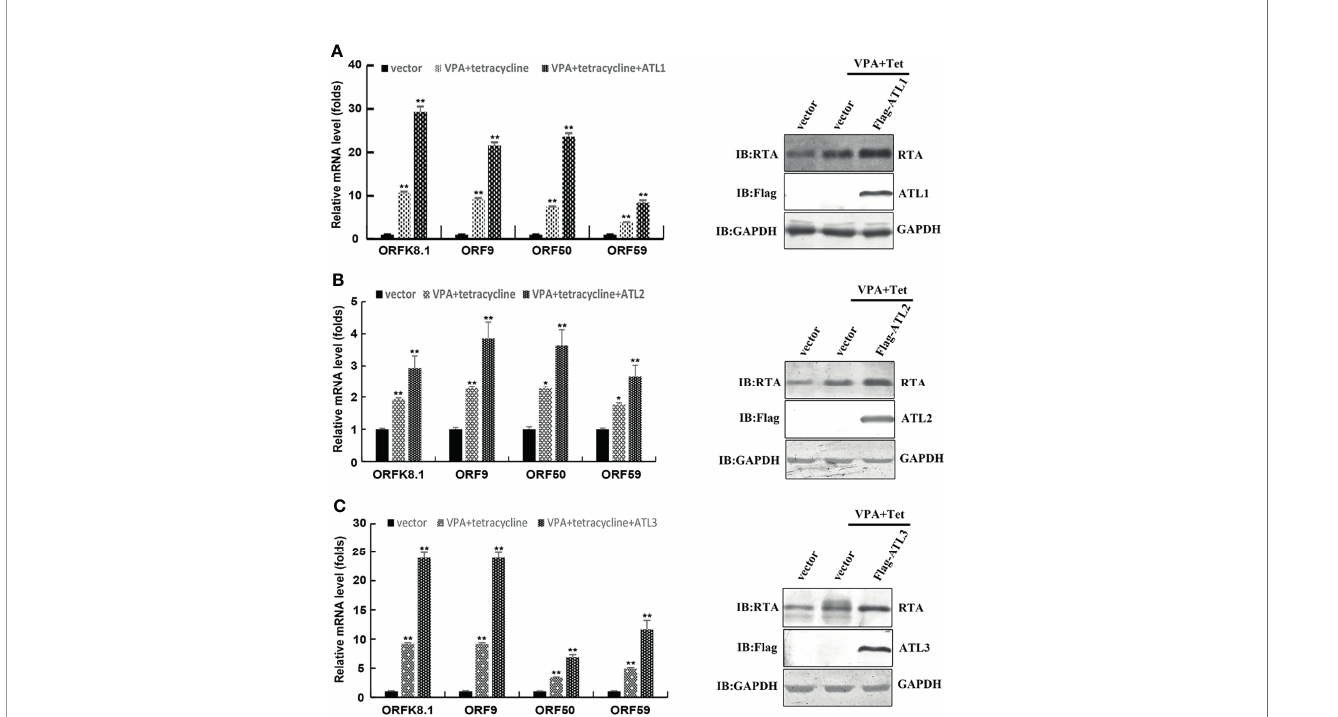
FIGURE 3 | ATLs overexpressionpromotes VPAinducedexpressionofKSHV lyticgenesiniSLK.rKSHV.219cells.iSLK.rKSHV.219cellsweretransfectedwithvector,ATL1, ATL2or ATL3respectivelyfollowedbytreatmentwithtetracyclineplusvalproate(VPA)for 48htoinduceKSHVlytic reactivation. TheeffectofATL1 (A) , ATL2 (B) ,andATL3 (C) onmRNA levels ofKSHVlyticgenes ORFK8.1 , ORF9 , ORF50 ,and ORF59 weremeasuredbyRT-qPCR, withnormalizationto actinusingthe DD CTmethod. Dataarepresented asmeans ofthree technicalreplicates(n=3,groupvaluesareindicatedbymean± SEM;*p<0.05; **p<0.01). Proteins weredetectedbywesternblotwithindicatedantibodies.